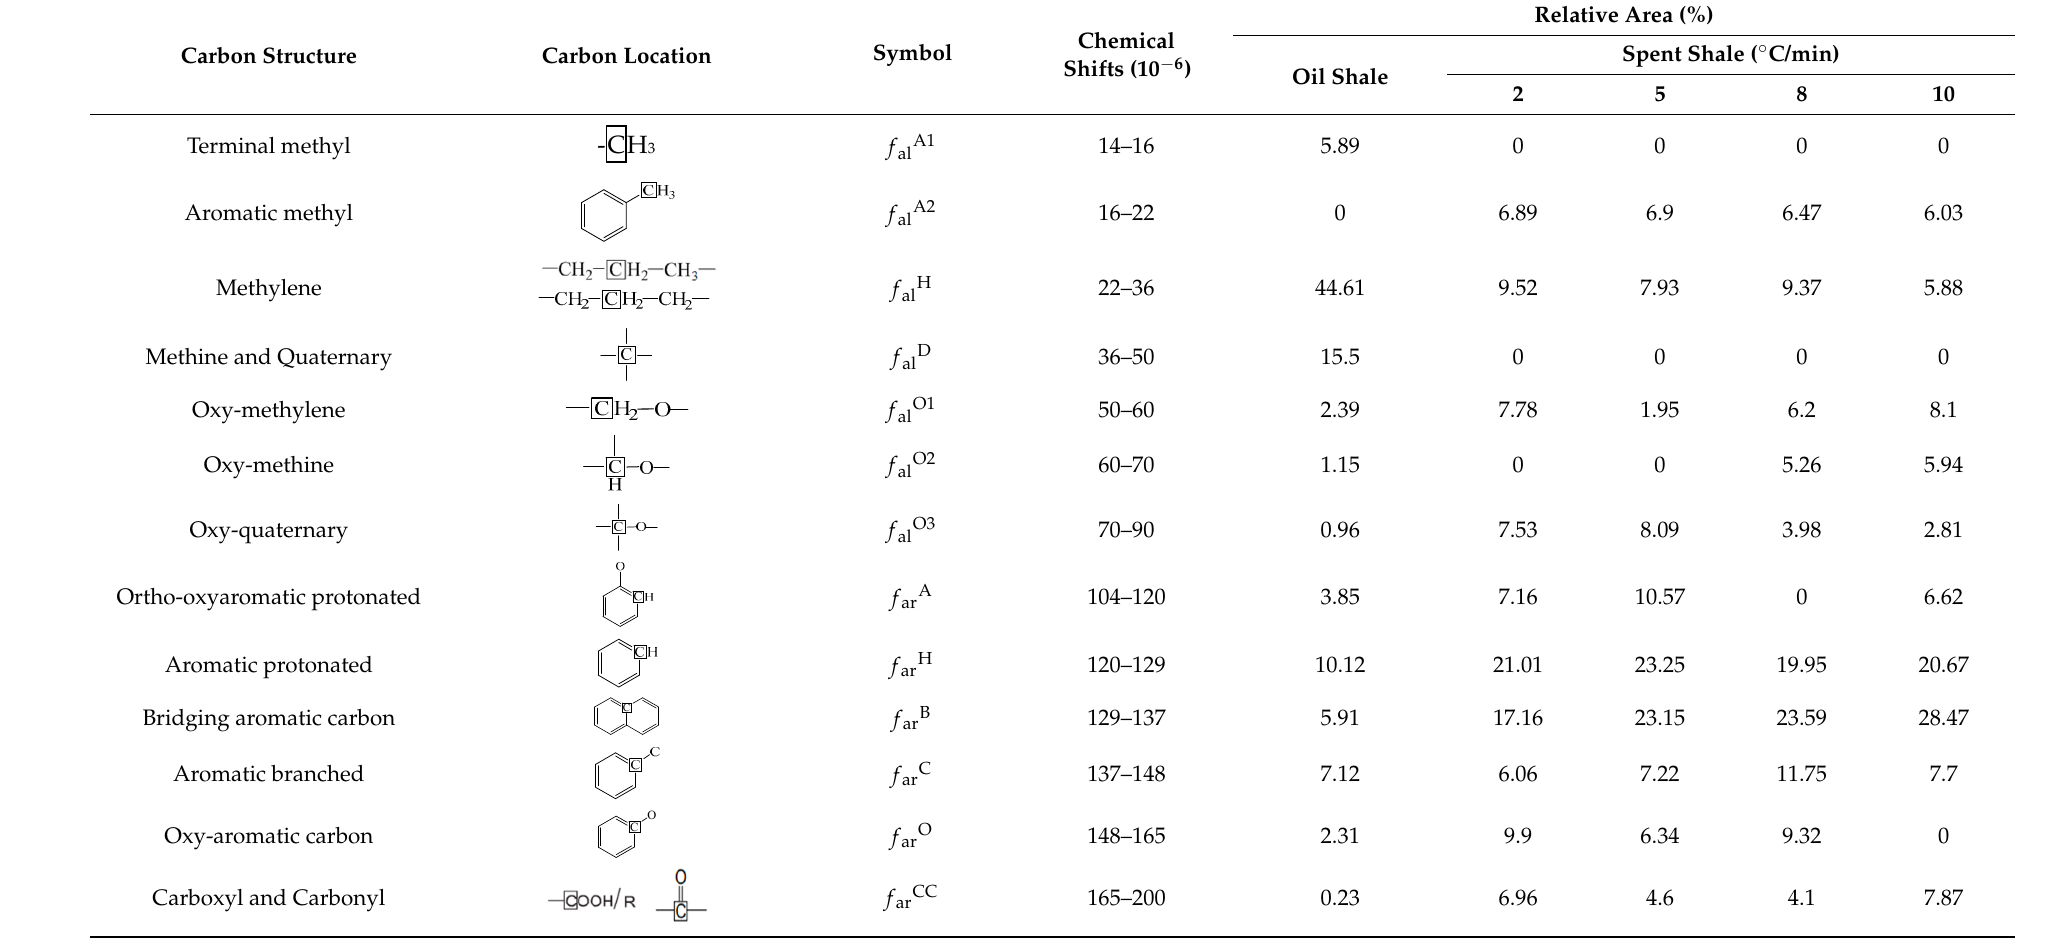
Table 2. Displacement and relative content of different types of carbon in Jimsar oil shale and its spent shale, obtained at different heating rates.